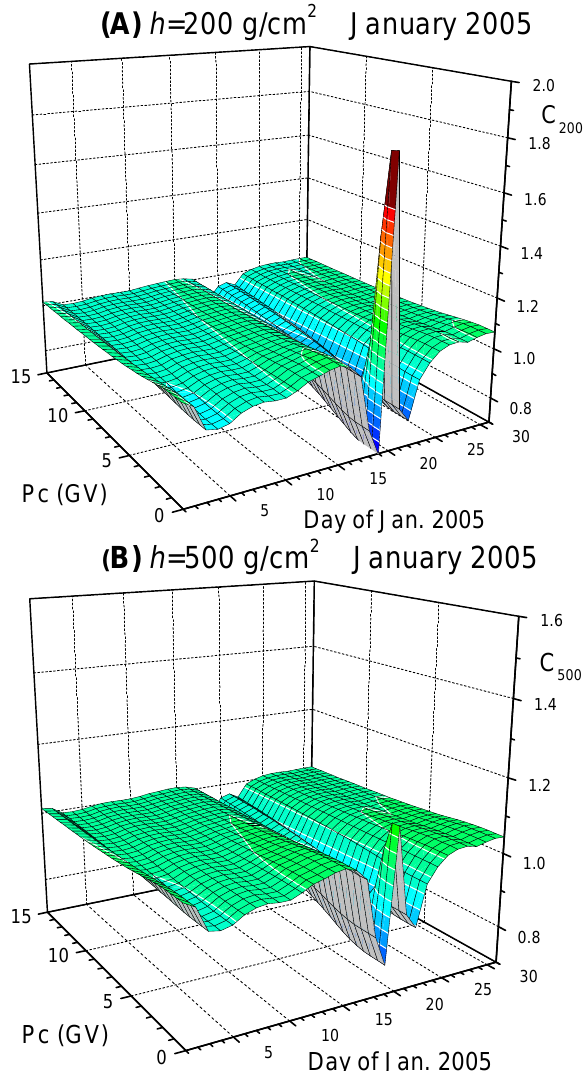
Fig. 4. The relative ionization C (normalized to the average ioniza- tion rate in January, 2005) as function of time and location ( P c ) for two atmospheric depths, 200g/cm 2 (panel A ) and 500g/cm 2 (panel B